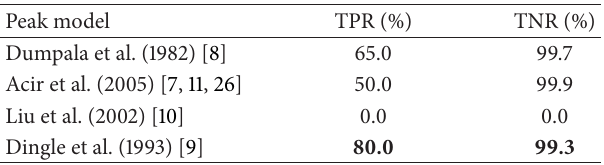
Table 8: TPR and TNR test results for EEG signal (without feature selection). Peak